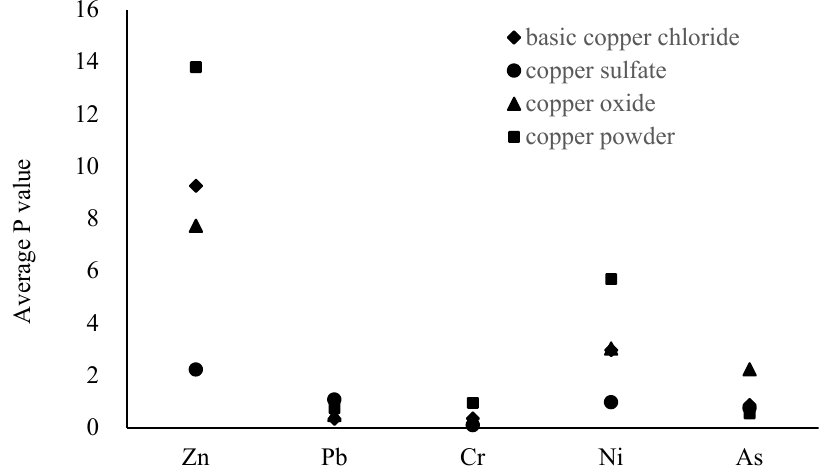
Figure 2. Average p -values of heavy metals for different types of recycled Figure 2. Average P- values of heavy metals for different types of recycled products.